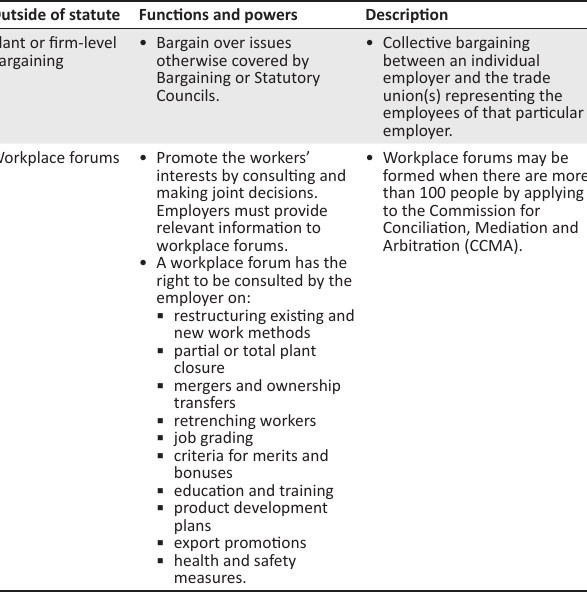
TABLE 2: Current levels of workplace collective engagement in South Africa.